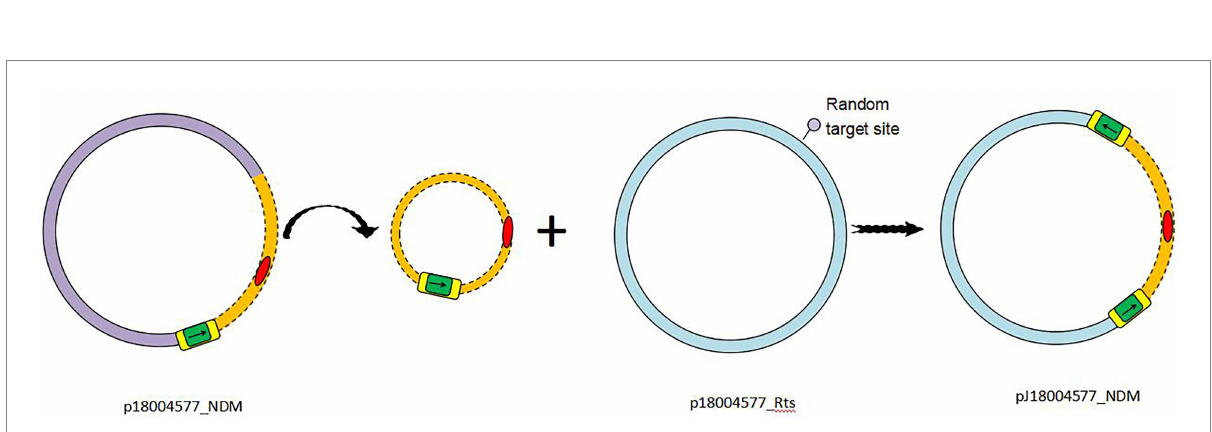
FIGURE 6 Schematic of transconjugant formation. IS26 is shaded green, with the left and right Δ ISKox2 shaded yellow. Antibiotic resistance genes are colored red. The p18004577_NDM backbone is colored light purple, whereas the p18004577_Rts backbone is light blue. Small black arrows indicate the orientation of the IS26 and Δ ISKox2